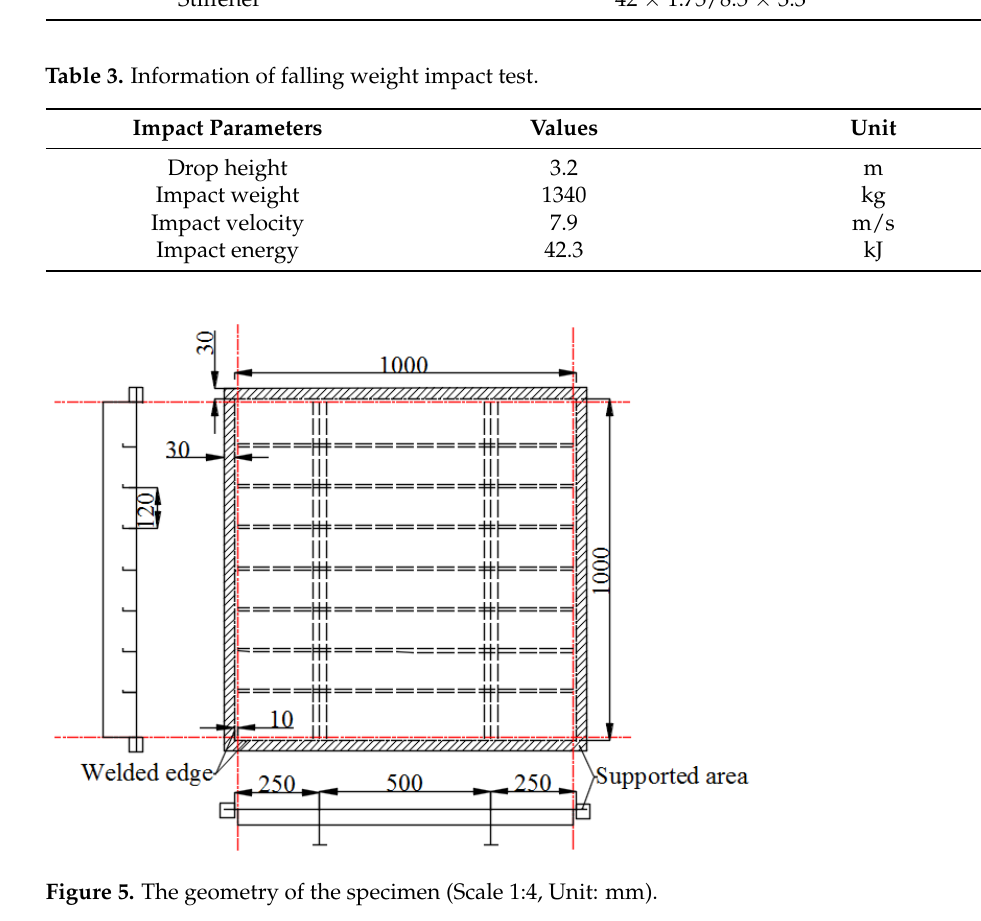
Figure 5. The geometry of the specimen (Scale 1:4, Unit: mm). Table 2. Dimension and thickness of stiffened panel.